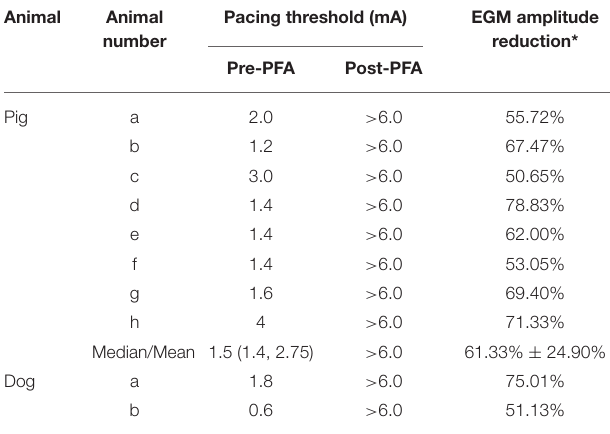
* The ablation records with voltage amplitude < 0.5mv before PFA or without voltage amplitude change before and after PFA were excluded. PFA, pulsed field ablation.